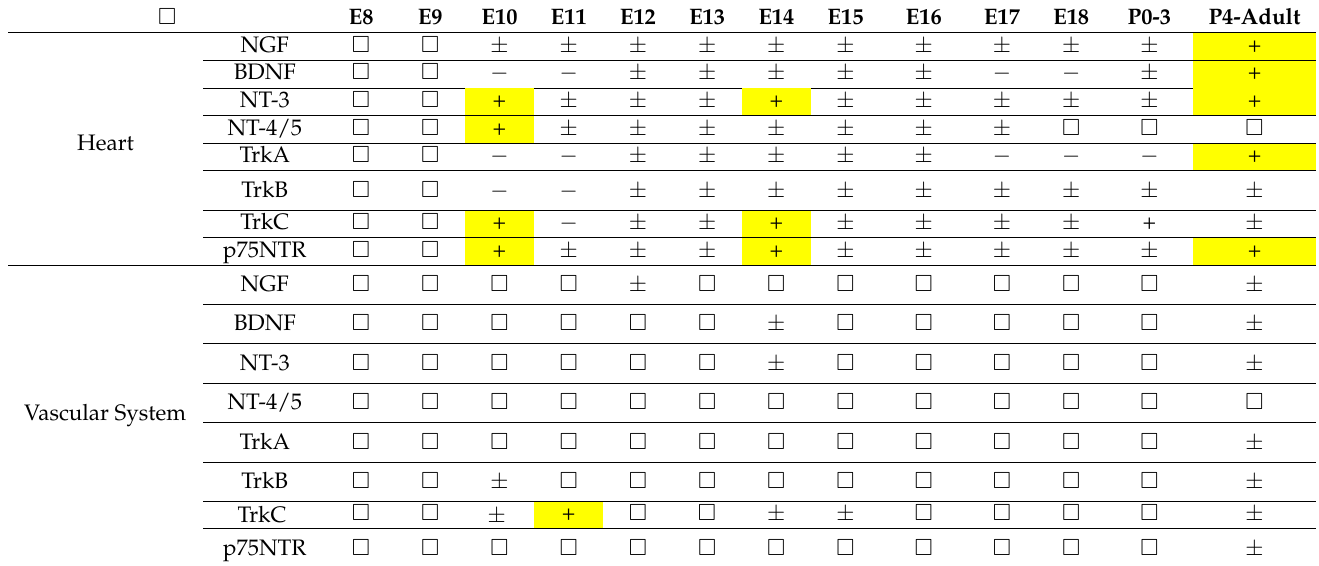
Table 1. Distributional pattern and relative mRNA expression levels of NTs and their receptors in the mouse heart and vascular system obtained from RNA-seq results provided by the Deciphering the Mechanisms of Developmental Disorders (DMDD) Program. Yellow boxes and “+” indicate a higher mRNA expression; “ ± ” lower expression; “ − ” no expression; blank denotes data not